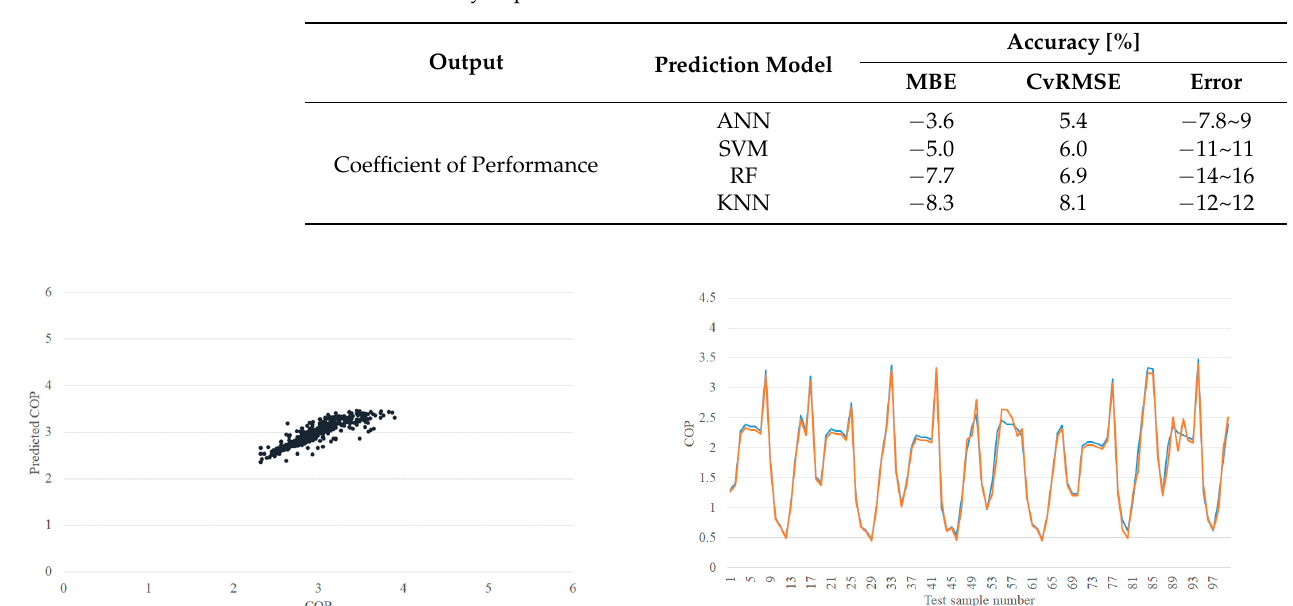
Figure 5. Comparison of predicted and measured performance using ANN model. Table 8. Accuracy of prediction model.